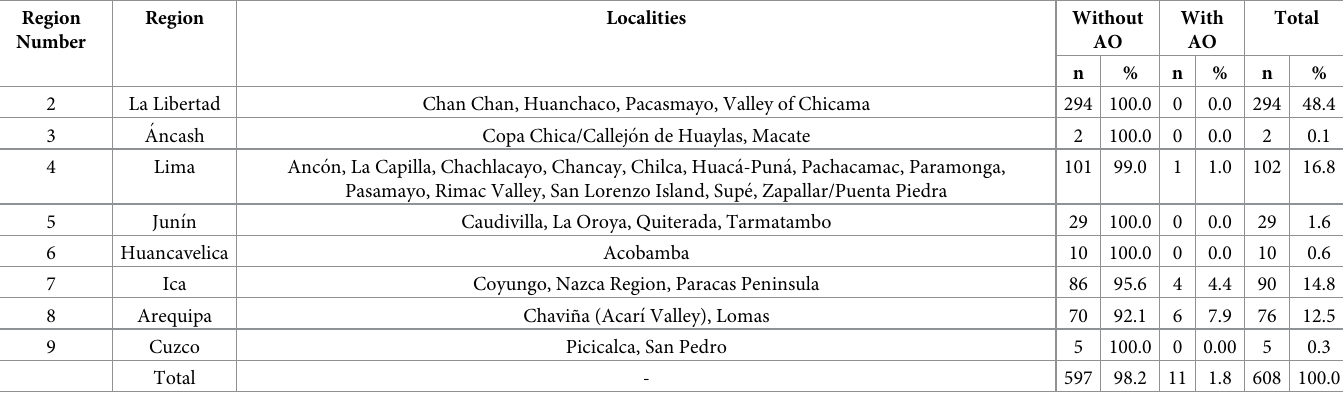
Table 1. Geographical distribution of atlas occipitalization (AO).